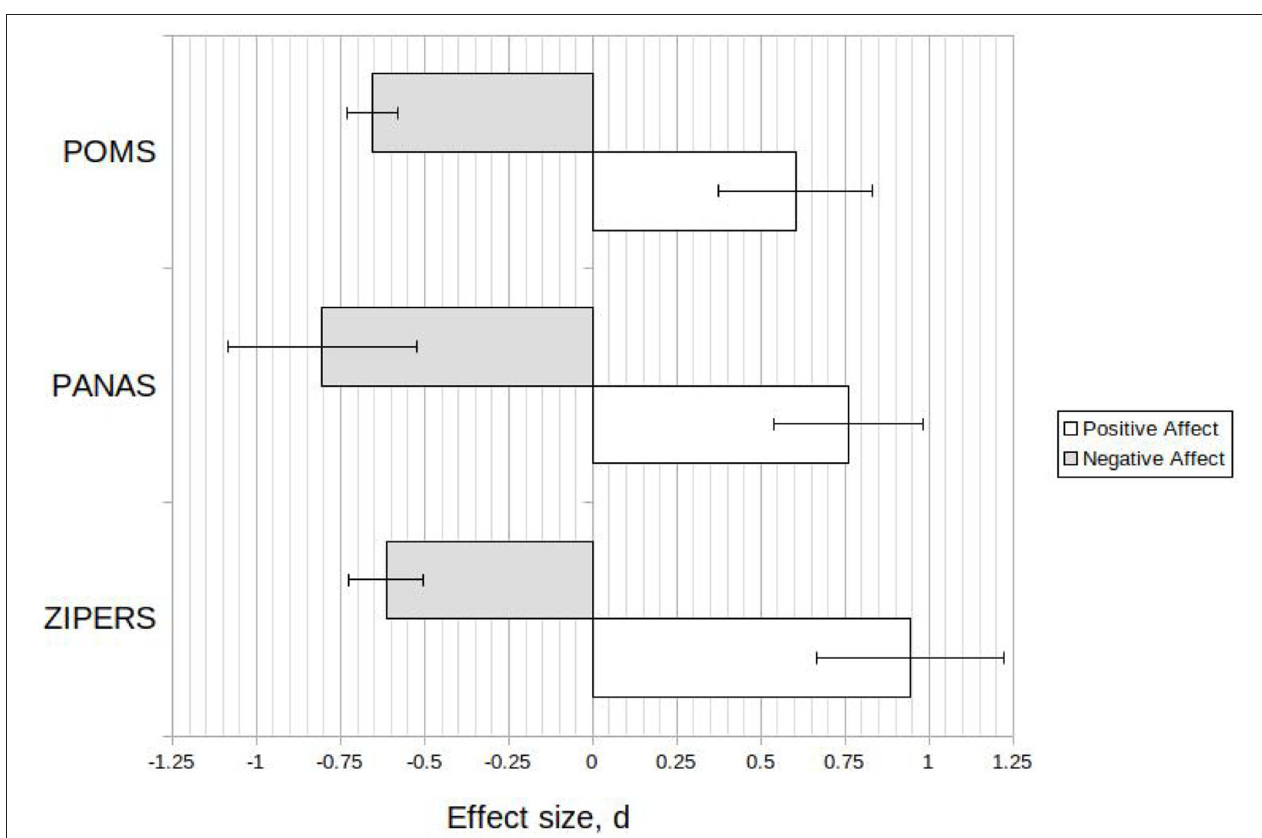
FIGURE 2 | Calculated effect sizes, d, for common outcome measures (Mean ±